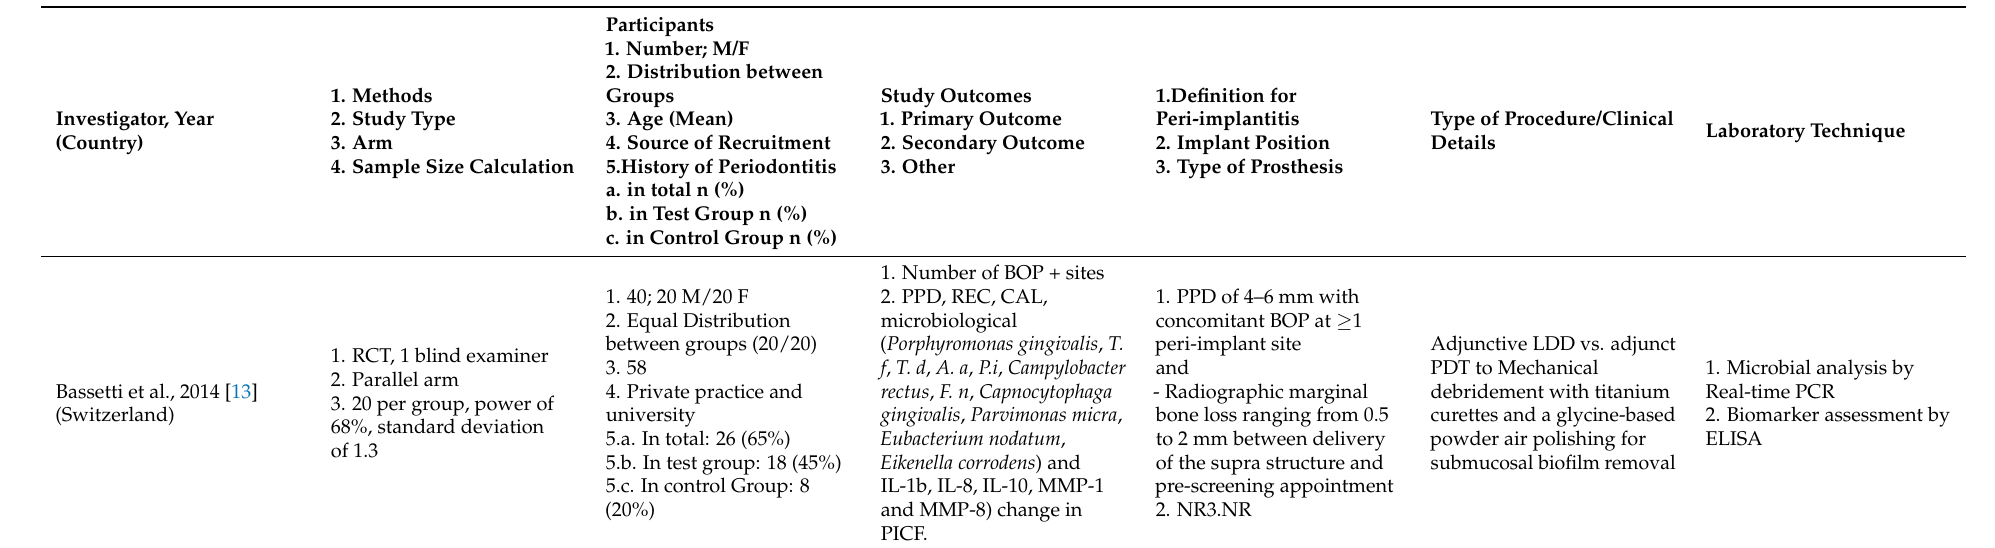
Table 1. Demographics and main characteristics of included studies. A.a: Aggregatibacter actinomycetemcomitans , AB: Antibiotic, ALP: Alkaline Phosphatase,